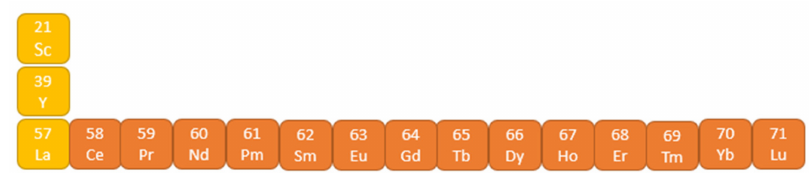
Figure 3. Group of rare earth